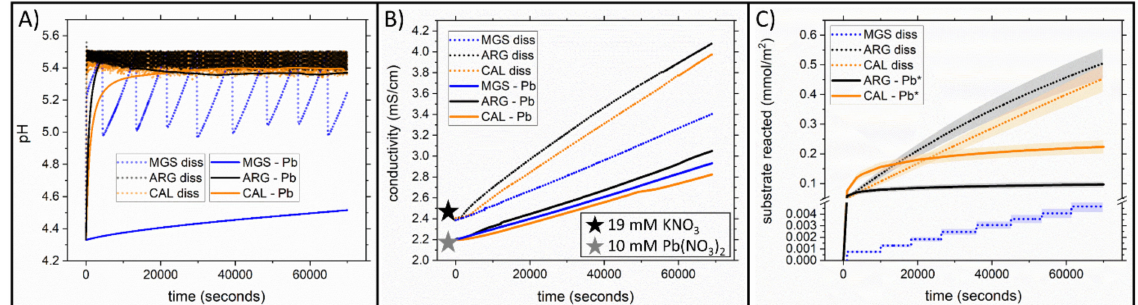
Figure 9. ( A ) Comparison between the evolution of pH in dissolution and recrystallization experiments for MGS, ARG and CAL. ( B ) Evolution of electrical conductivity in absence and in presence of Pb 2+ . The star symbols refer to the conductivity of the respective solution calculated with PHREEQC. ( C ) Comparison between the amount of substrate that reacted during the dissolution of MGS, ARG and CAL and the amount of substrate reacted during the batch recrystallization experiments in presence of Pb 2+ . The experiments labelled with the asterisk (in Figure 9C) refer to literature values from